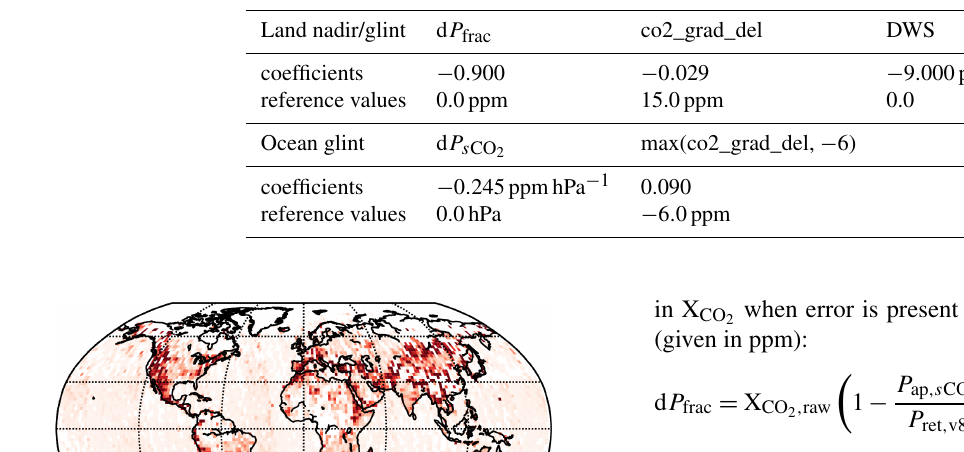
Table 4. Parametric bias correction coefficients and reference values for v9 over land and ocean.